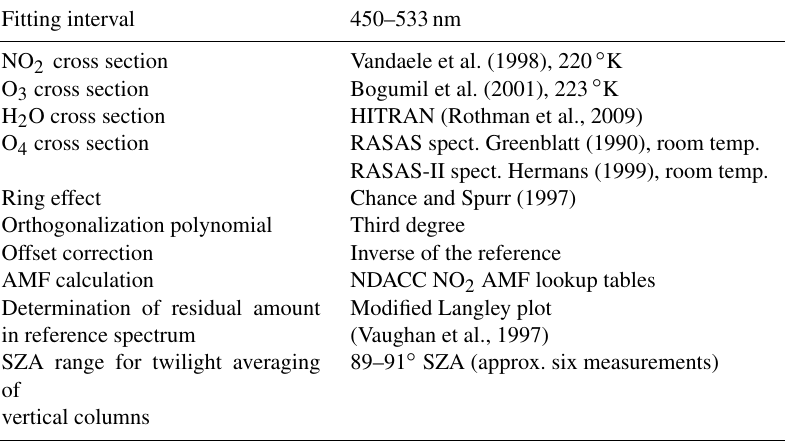
Table 1. DOAS spectrometers settings. Fitting